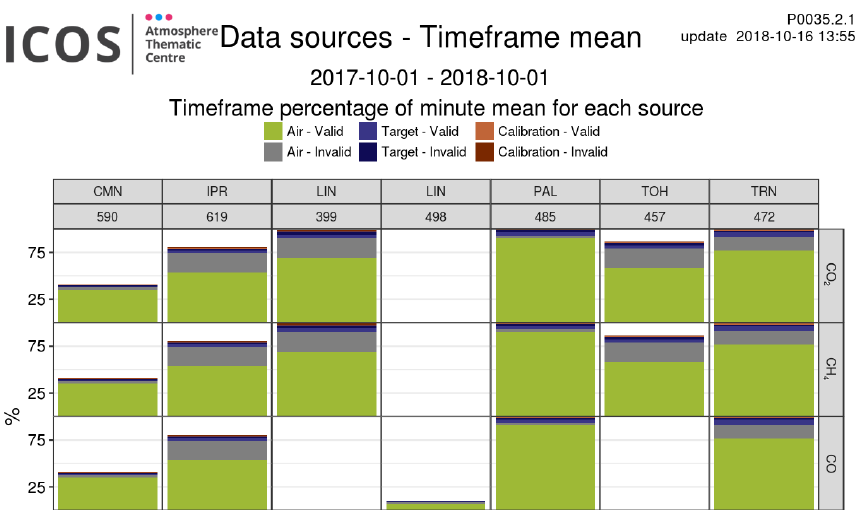
Figure 4. Data distribution between ambient air and target and calibration gases for the same six stations as Fig. 3 for CO 2 , CH 4 and CO. Calibration is in red, target in blue and air in green/gray. Gray and darker colors are invalid data. Less than 100% data availability means that the instrument was installed less than 12 months ago. The first line shows the station acronym and the second line the instrument ICOS ID. In the case of LIN, two instruments are used to measure CO 2 , CH 4 and